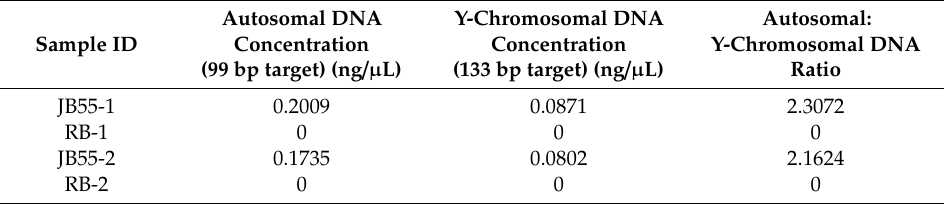
Table 1. Plexor HY DNA quantification results from JB55 extracts 1 and 2, and corresponding